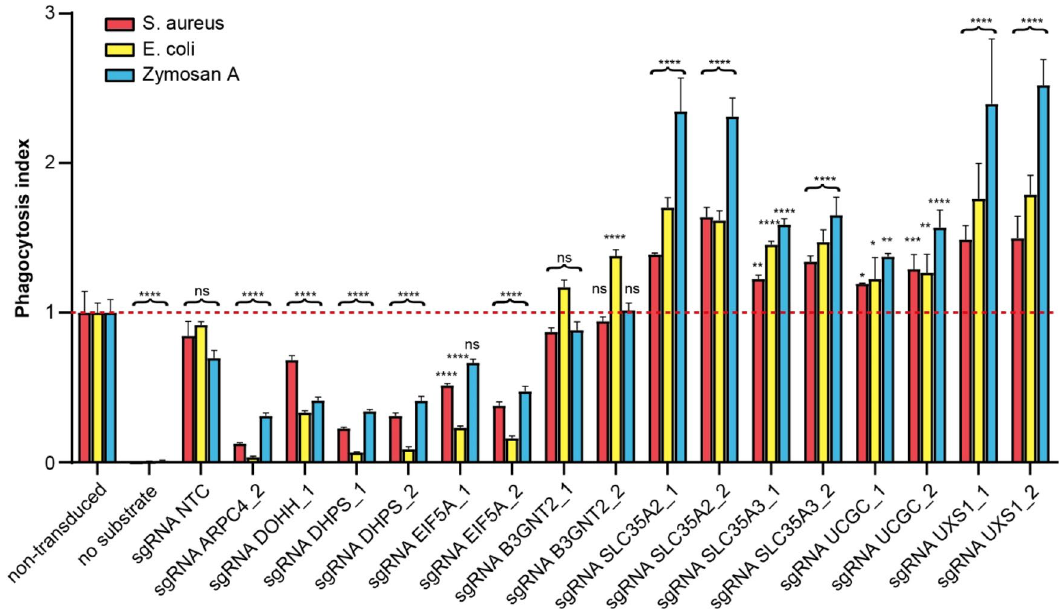
Figure 4. Validation of hits of EIF5A and related genes and genes involved in UDP-glycosylation pathway. THP-1 iCas9 cells were transduced with guides targeting indicated genes or with non-targeting control (NTC) and Cas9 expression was induced with dox. On day 12 after gene knockout, S. aureus , E. coli and zymosan A particles labeled with pHrodo red were added and phagocytosis was measured 1 h later using flow cytometry. Depicted is the mean phagocytosis index of live Thy1.1 + cells of 2–5 replicates ± SEM. The phagocytosis